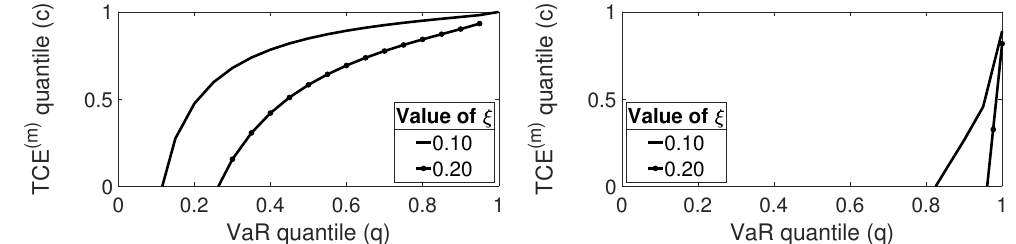
Figure 6. Extended TCE quantile as a function of VaR quantile. ( Left panel ): m = 3, σ = 0.1, and µ = 0. ( Right panel ): m = 3, σ = 0.4, and µ =